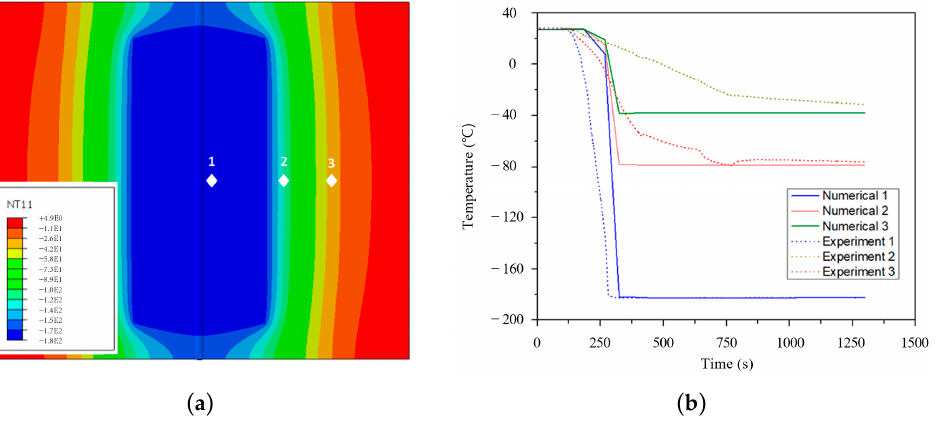
Figure 14. Validation of temperature distribution between simulation and experiment for ( a ) the measured points, and ( b ) comparing numerical results to experiment data.